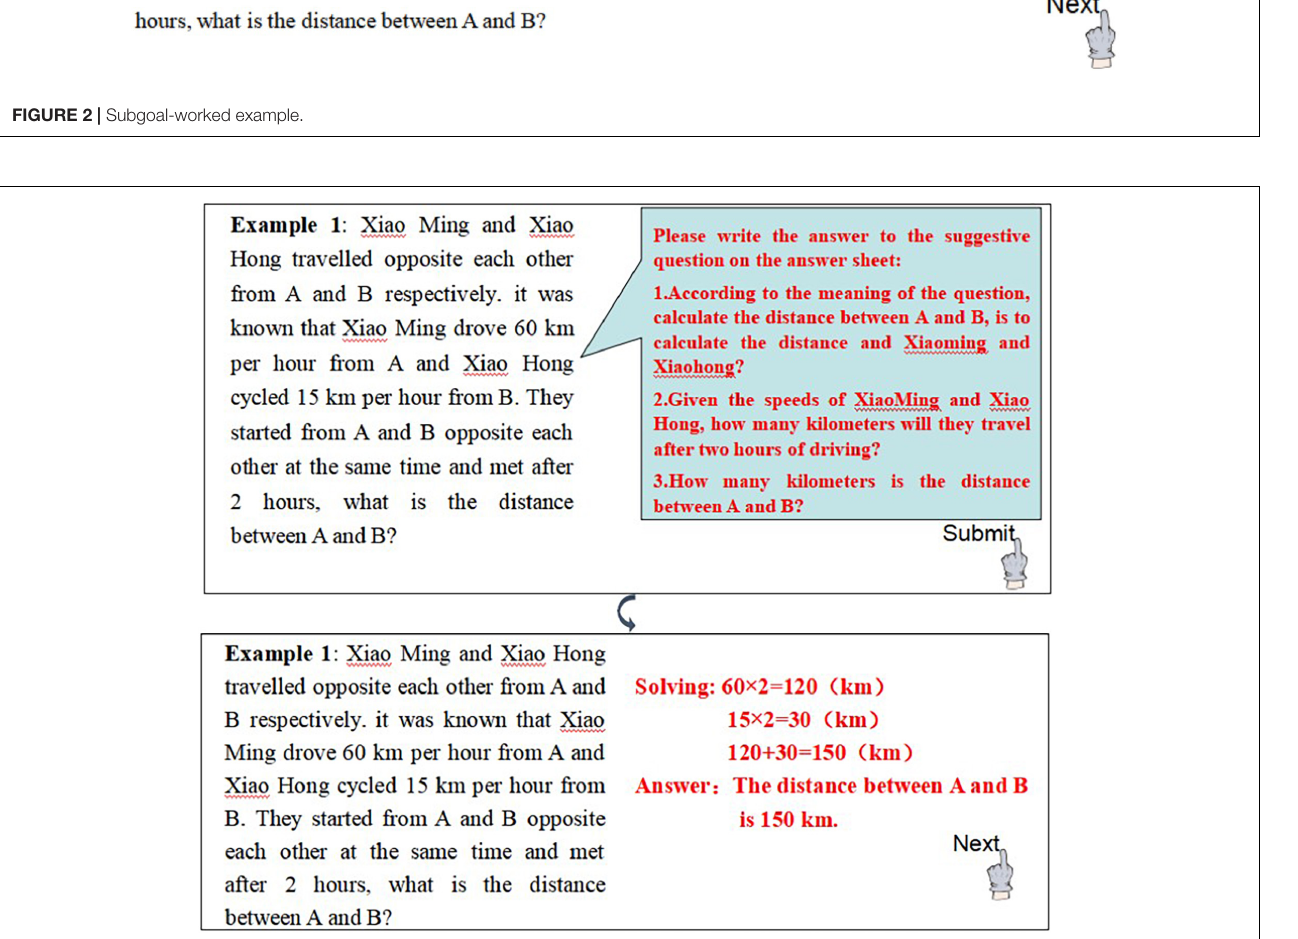
FIGURE 3 | Focused subgoal-labeled worked